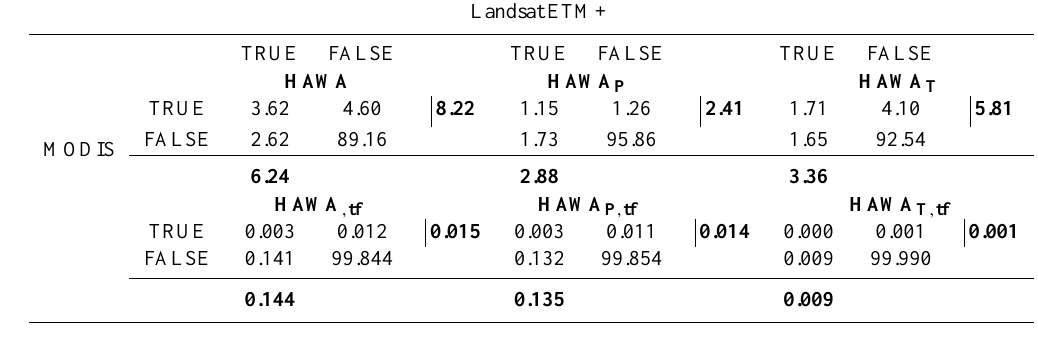
Table 2. Comparison of HAWA land cover and HAWA subtype cover mapped using Landsat ETM+ and MODIS data in a 2 × 2 contingency table. Bold numbers refer to total cover of HAWA and HAWA subclasses for each HAWA mapping result. Landsat ETM+